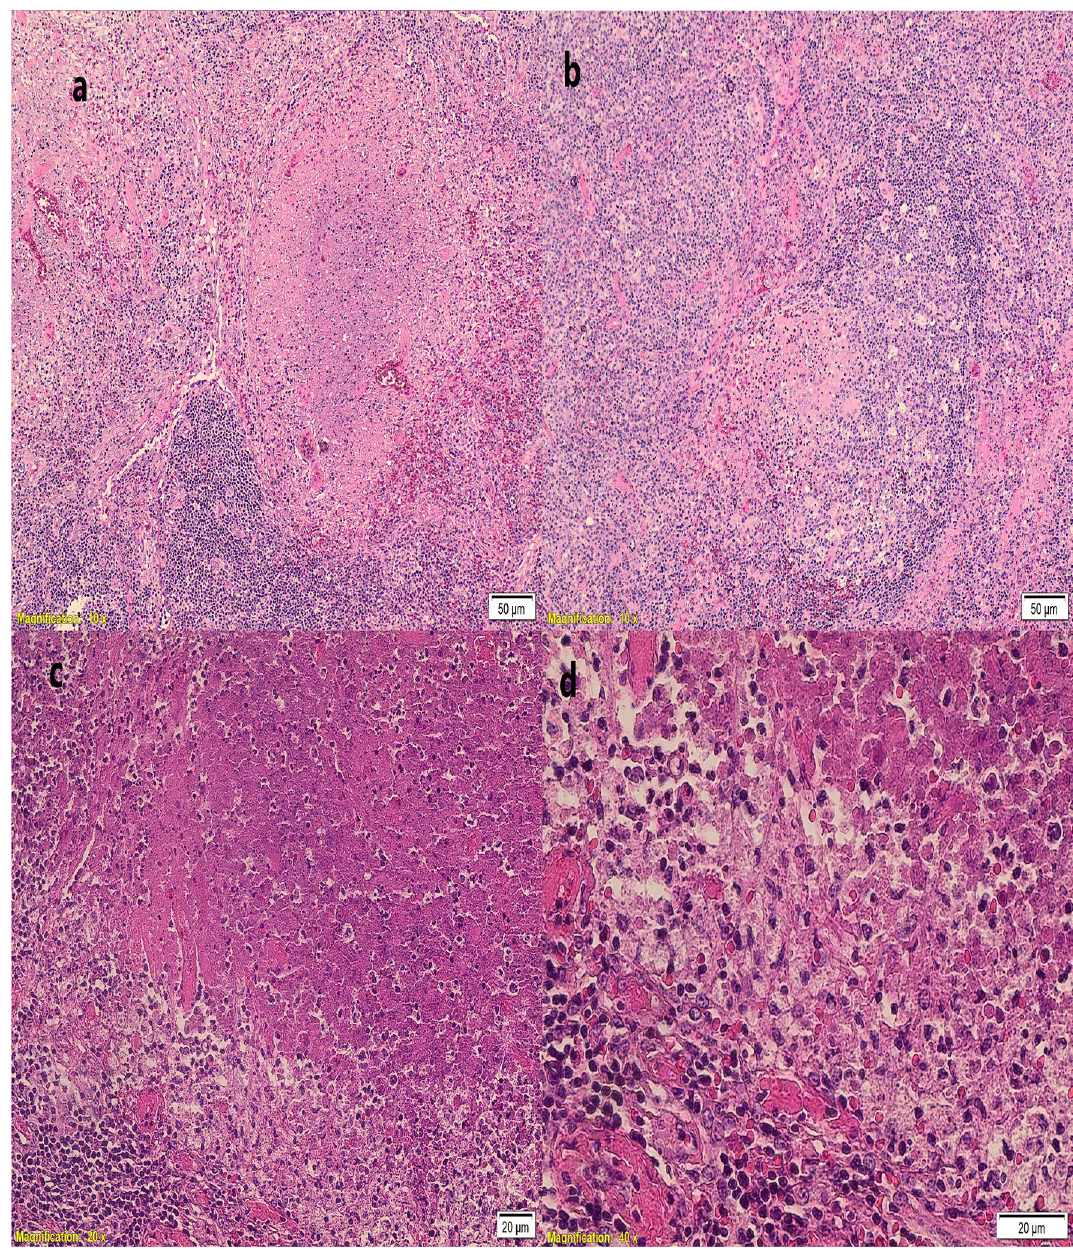
Figure 1. Lymph node from a patient with KFD. ( a , b ) The lymph node architecture is effaced by areas of confluent necrosis. ( c , d ) Higher magnification show karyorrhectic debris within necrotic foci which are surrounded by mononuclear cells including histiocytes and